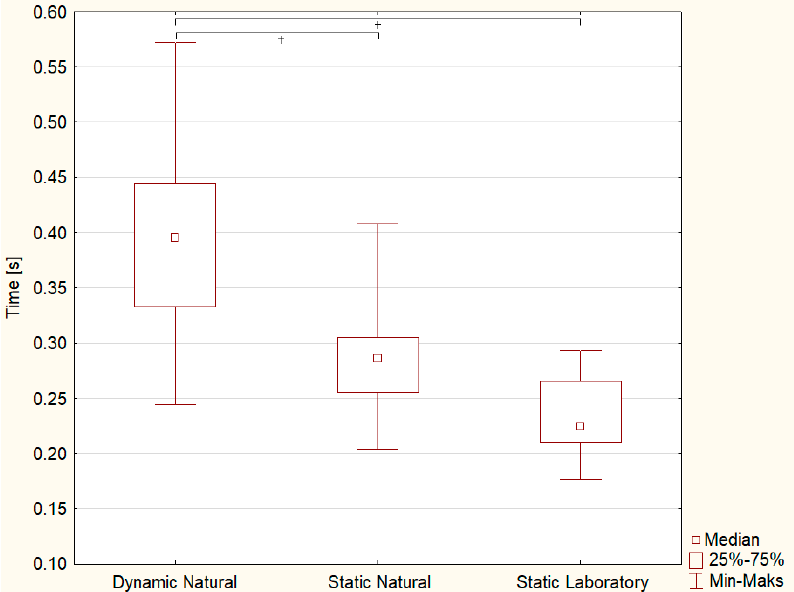
Figure 6. Box–whiskers plot of mean visual simple reaction time (s) under selected conditions in girls group (small box: median, box: first (25%) and third (75%) quartile, whiskers: minimum (Min) and maximum (Maks), cross (+): significant difference).